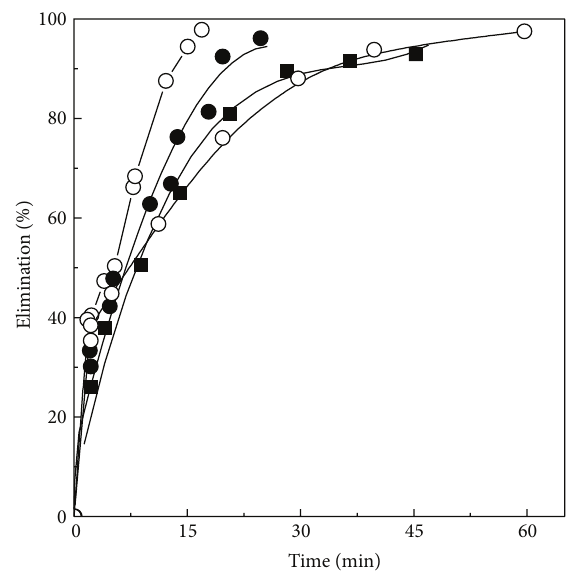
Figure 2: Sunlight influence on the AYL ( 5.8 ⋅ 10 −5 M) oxidation withFenton’sreagent[H 2 O 2 ] 0 (M): 1⋅10 −3 (circle)(darkconditions); 1 ⋅ 10 −3 (box); 5 ⋅ 10 −4 (black circle) ( ∙ ), 3.3 ⋅ 10 −4 (black box) ( ◼ ).